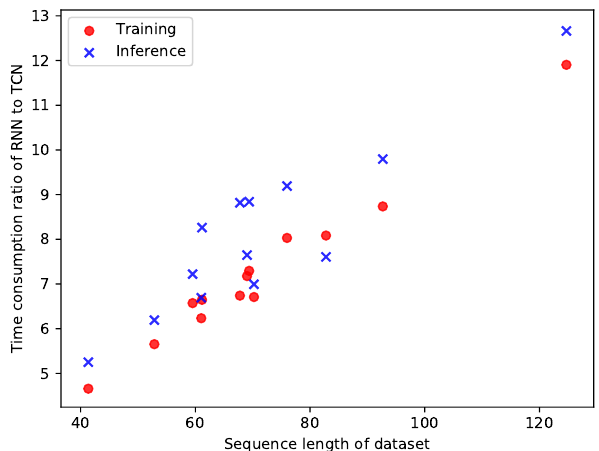
Figure 14. Training and inference time ratios of RNN to TCN by sequence length.